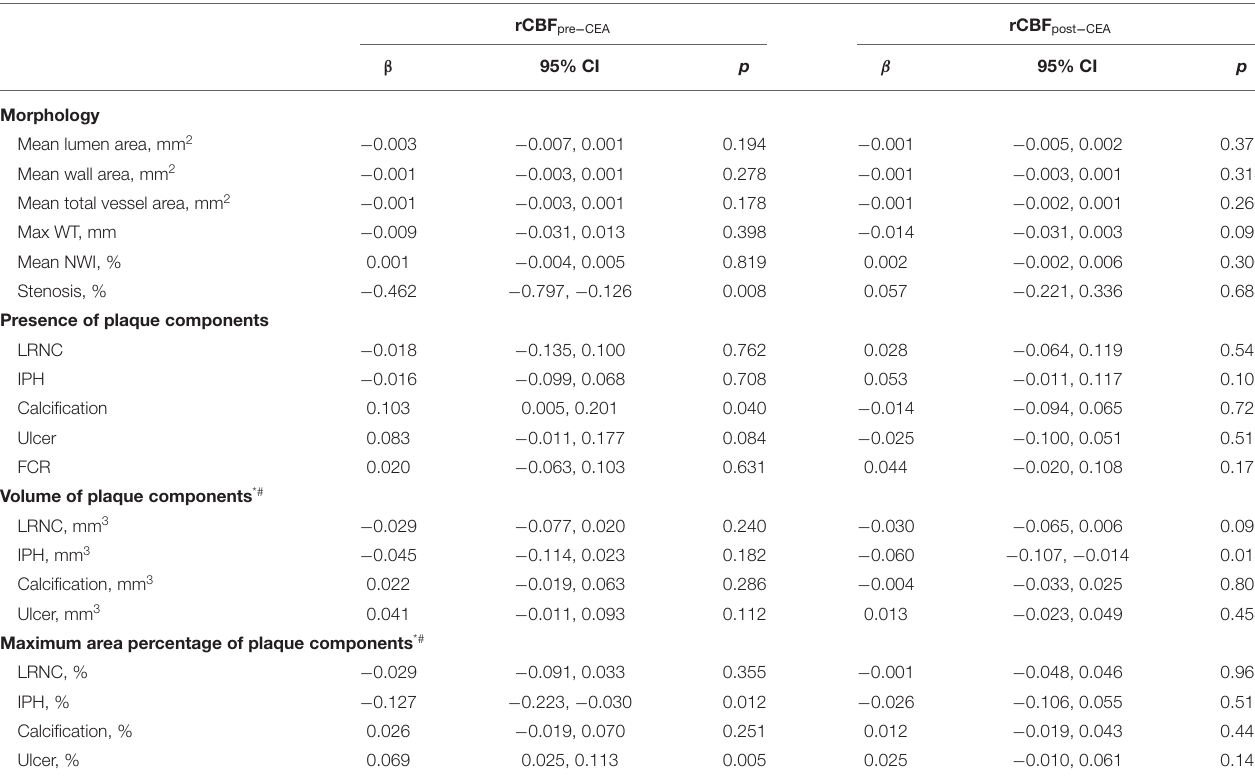
TABLE 4 | Univariate linear regression analysis between plaque characteristics and CBF ( n =